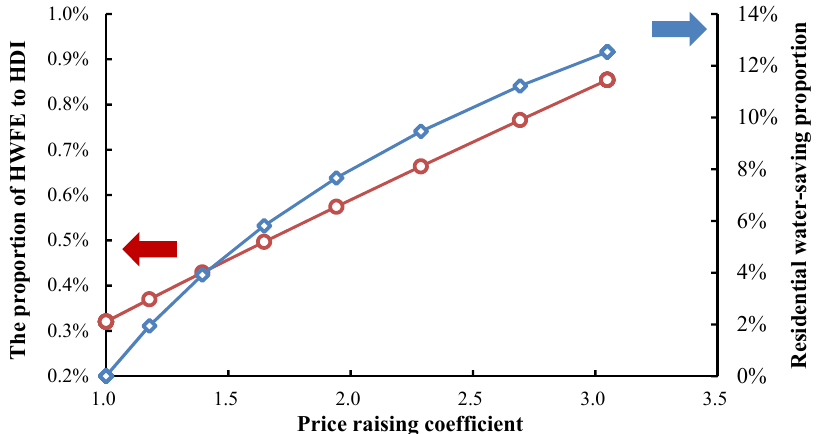
Figure 8. The curves of the residential conserved water proportion and the proportion of HWFE to HDI with the change of price raising coefficient.